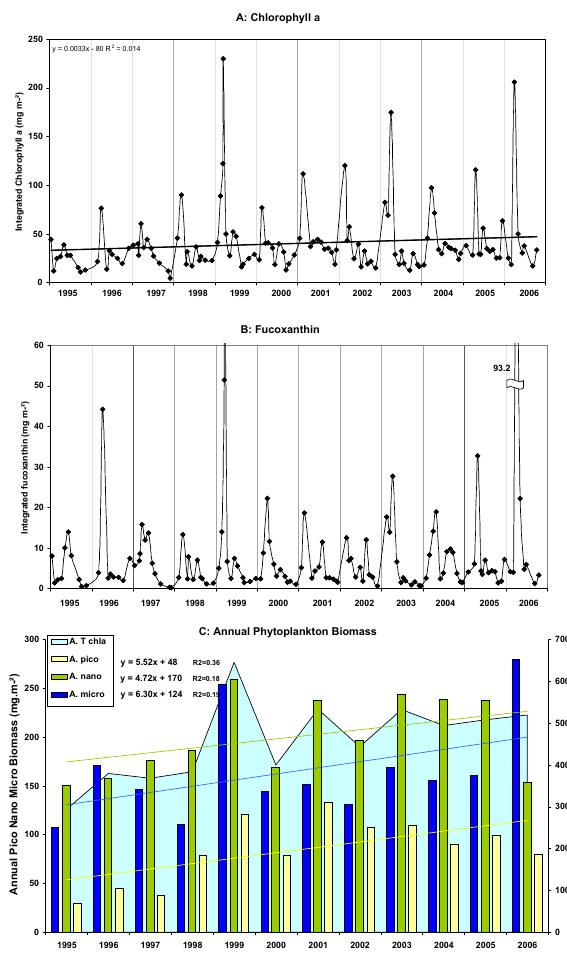
Fig. 10. (A) 1995–2006 time-series of integrated chlorophyll a over the 0–200m layer (inmgm − 2 ) and regression line (slope 1.2mgm − 2 y − 1 ) . (B) 1995–2006 time-series of integrated fucox- anthin. (C) Annual integrated phytoplankton biomass (0–200m) for total Chlorophyll a and three algal sized classes (pico, nano and micro phytoplankton) and regression lines. A. T chl a : an- nual chlorophyll a ; A. pico: annual picophytoplankton; A. nano: annual nanophytoplankton; A. micro: annual microphytoplankton; see text for